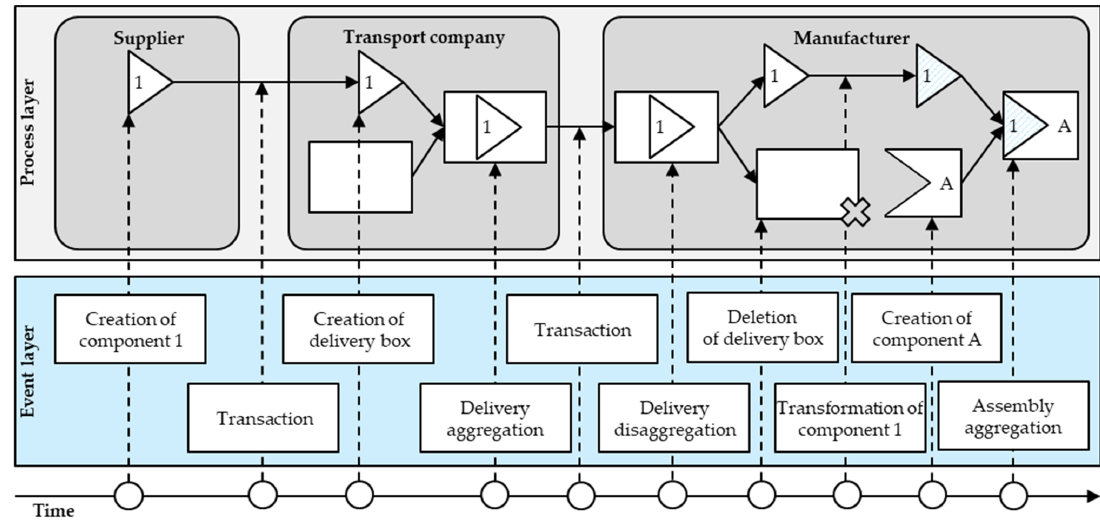
Figure 9. Example of a supply chain used to demonstrate the dApp’s workflow.